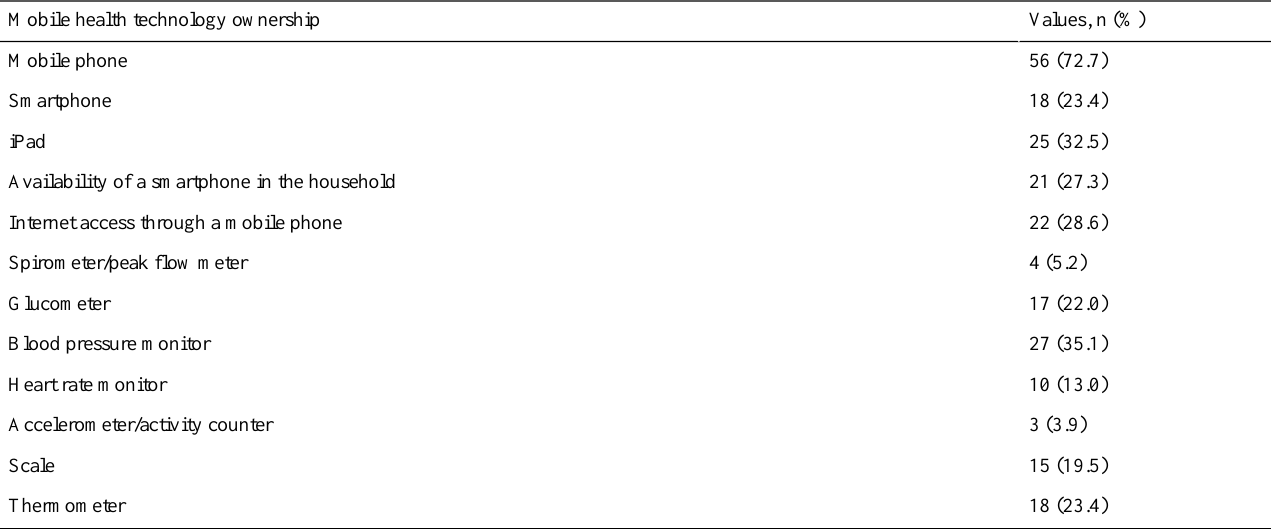
Table 2. Mobile health technology ownership